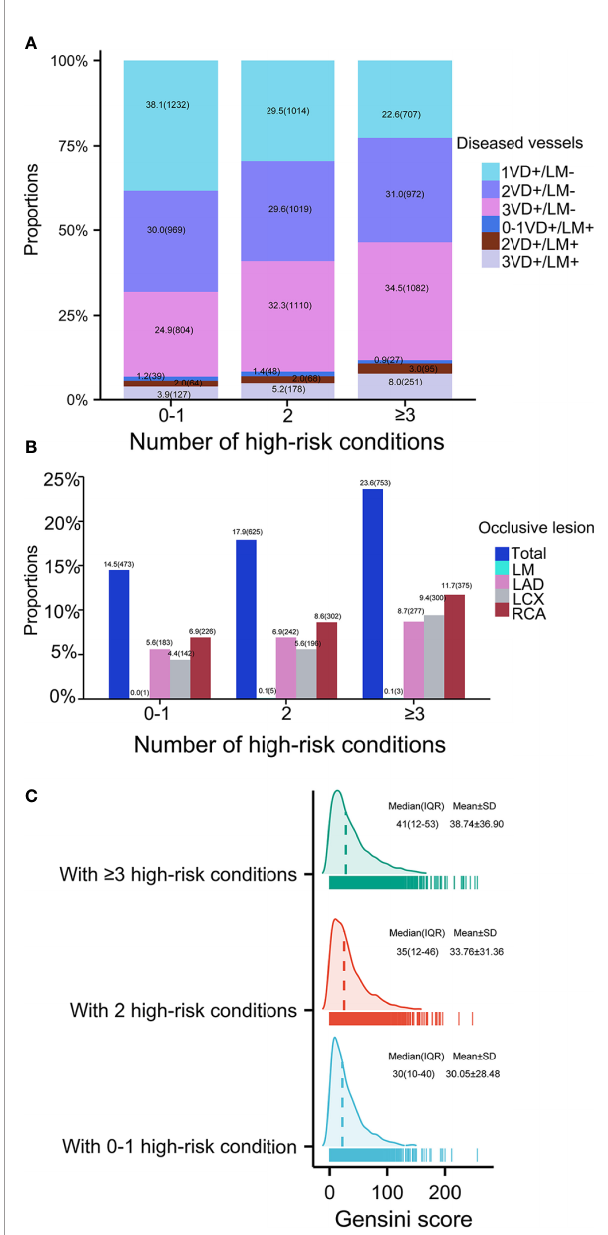
FIGURE 2 | Coronary severity according to number of high-risk conditions. Coronary severity was assessed by (A) number of diseased arteries, (B) occlusive lesion, and (C) Gensini score. VD, vessel disease; LM, left main; LAD, left anterior descending; LCX, left circum fl ex; RCA, right coronary